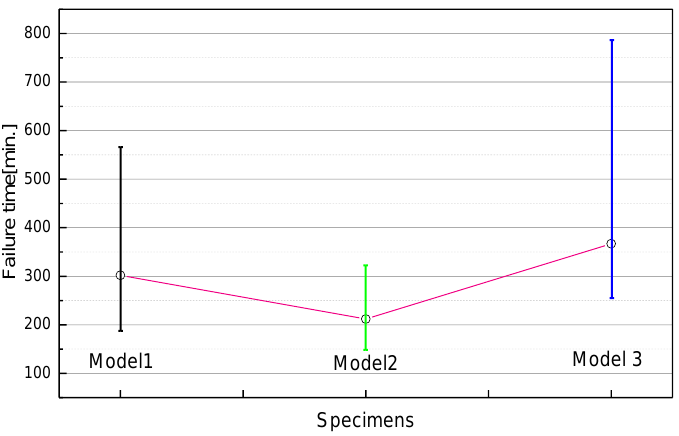
Figure 8. Time of failure according to tree models.